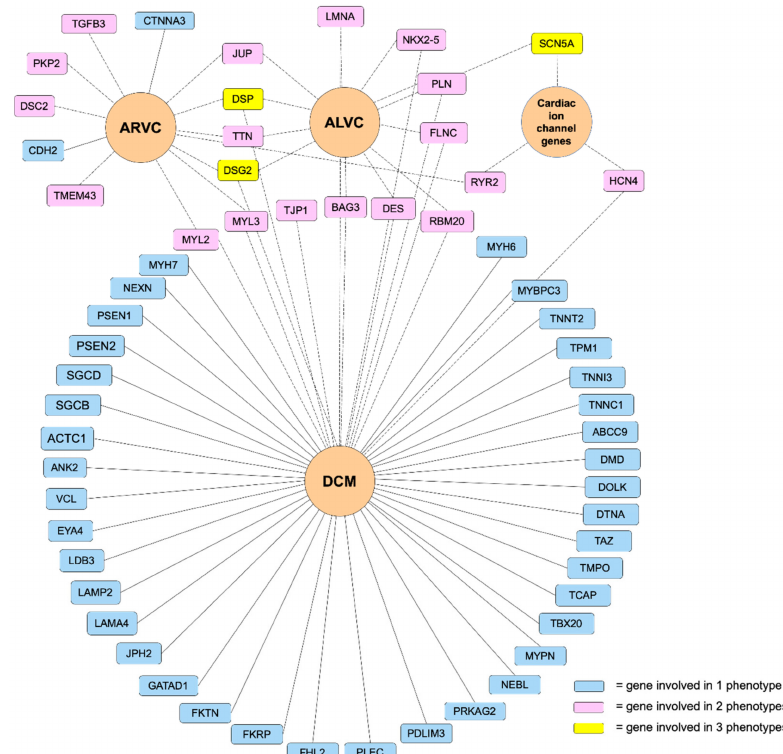
Figure 3. Genetic mutations associated with arrhythmogenic cardiomyopathy. Overlapping genetic determinant implicated in ACM identified from our clinical experience. ACM = arrhythmogenic cardiomyopathy; ALVC = arrhythmogenic left ventricular cardiomyopathy; ARVC = arrhythmogenic right ventricular cardiomyopathy; DCM = dilated